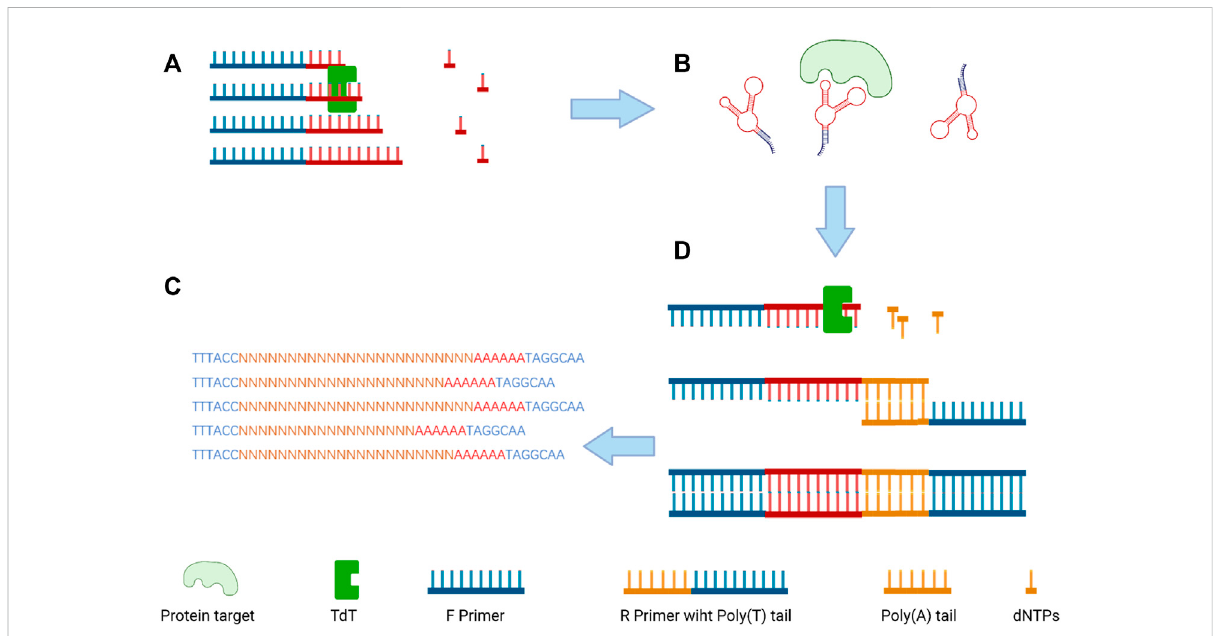
FIGURE 4 Overviewoftheselectionsize-dependentsingle-roundselectionofprotein-bindingpolynucleotide usingvs-DNAlibraries; (A) thesynthesis of a random ssDNA library via TdT; (B) the separation of the protein – ssDNA complex; (C) the addition of poly-A tail by qPCR ampli fi cation to dsDNA; and (D) next-generation sequencing (NGS) to analyze the sequences of the candidate aptamer (Ashley et al., 2021).